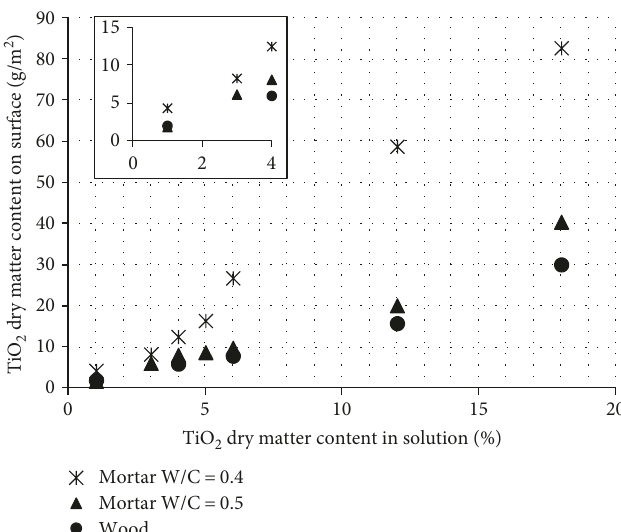
Figure 4: Correlation between TiO dry matter content in solution (%) and TiO 2 content of TiO on the surface was obtained by dividing the total TiO 2 of TiO in solution. Each point is the mean value of three samples (cf. Figure 5). 2